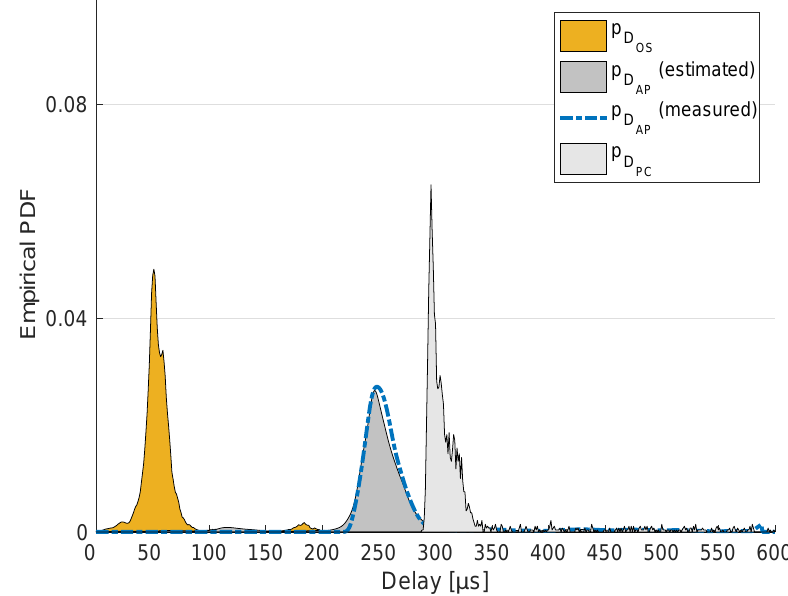
Figure 9. Result of the estimation for the Siemens Scalance W784-1 AP, and a comparison between the measured and estimated AP